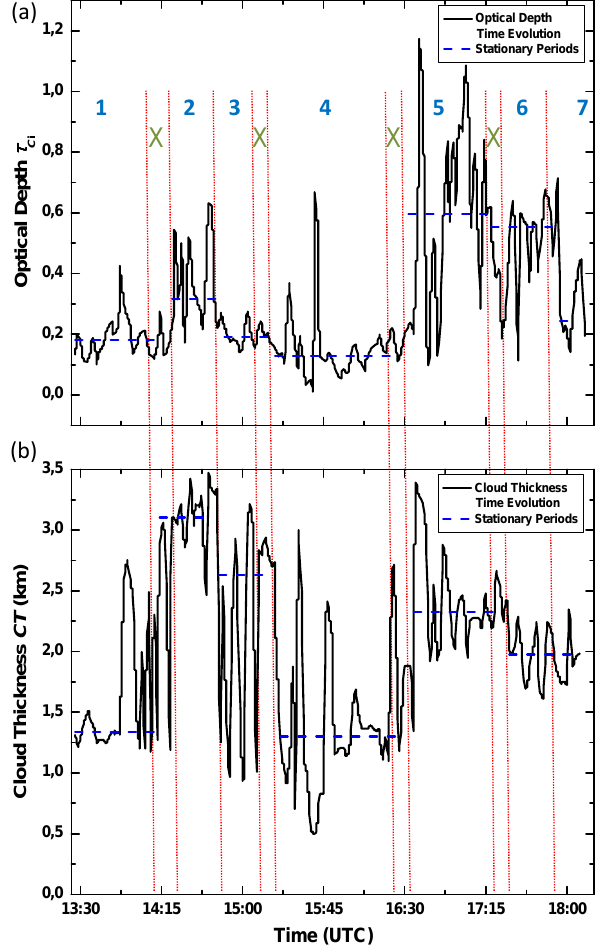
Fig. 5. Variation in time of (a) optical depth ( τ cir ) and (b) cloud (geometrical) thickness (CT) for the altitude range between 8 and 11.5km height as obtained from the MSP-lidar system observa- tions. The black continuous line represents the variations on τ cir and CT. The blue horizontal dashed lines represent the medians that define the stationary periods. Any contrary trend as verified simul- taneously between the τ cir and CT values corresponding to the in- terval marked as green “X” were removed from the sequence.